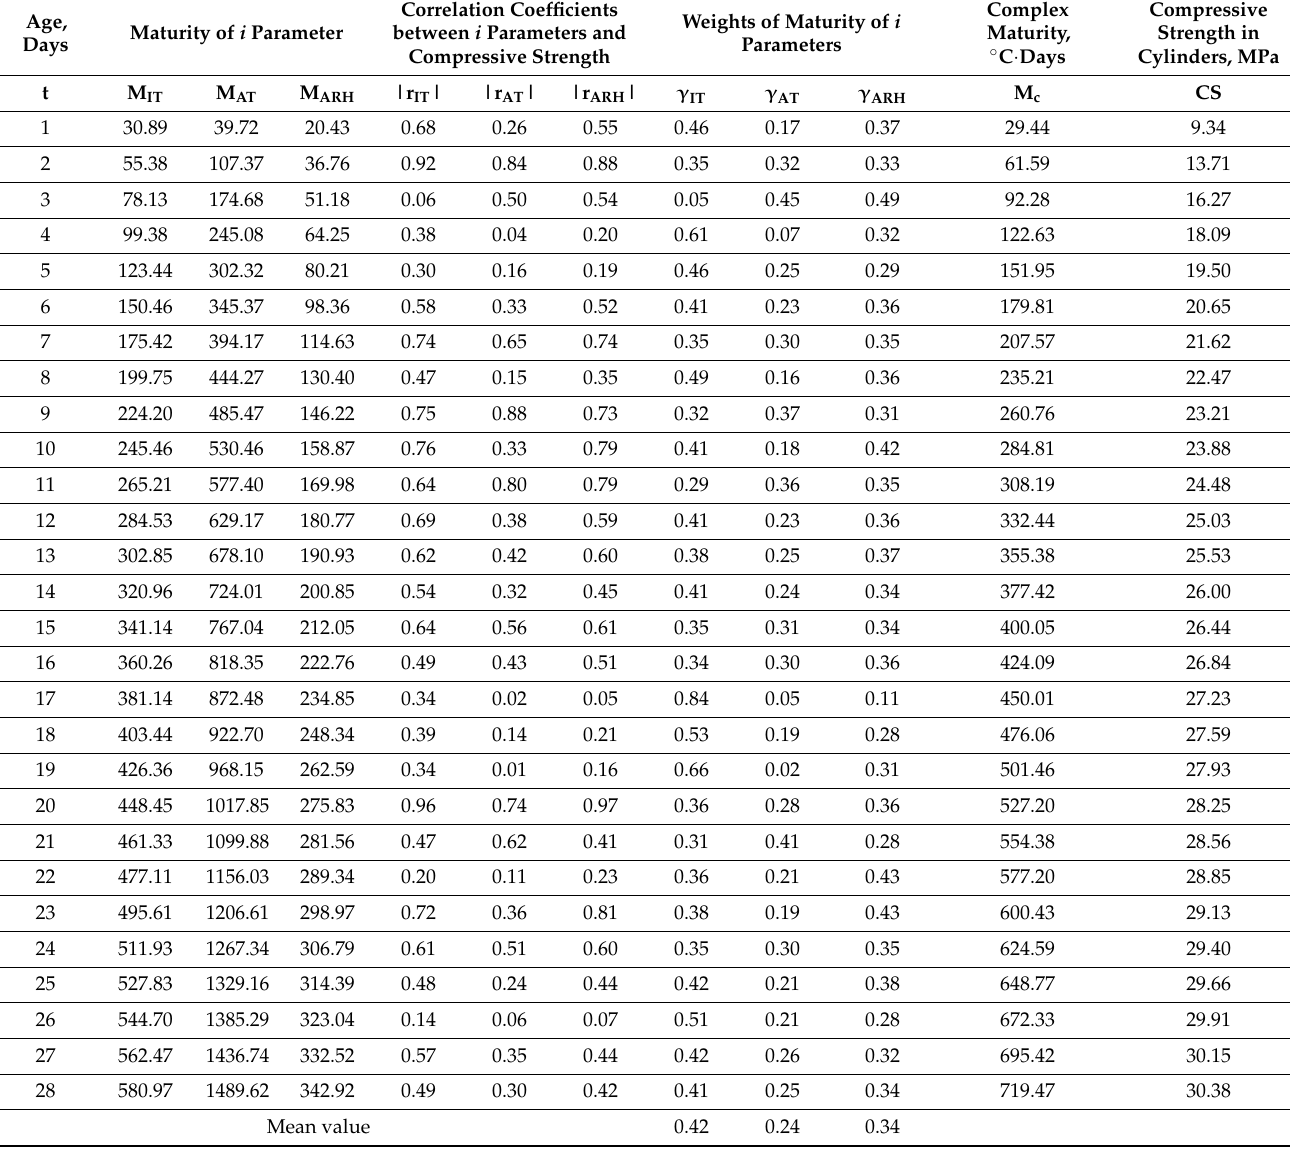
Table 2. Calculation of complex maturity-strength relationship for laboratory cylinders.